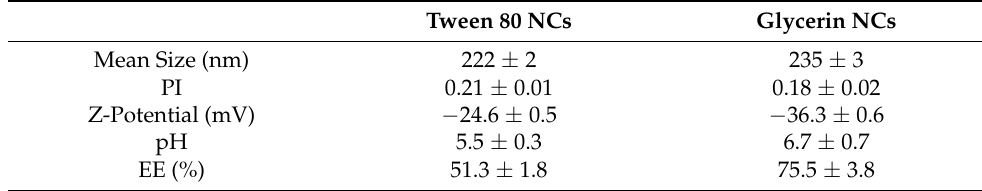
Table 1. Characterization of NCs prepared with Tween 80 vs. glycerin as moisturizers.